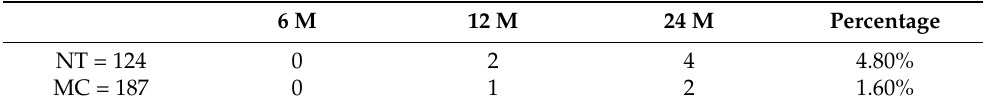
Table 3. The prevalence of peri-implant mucositis after 6, 12, and 24